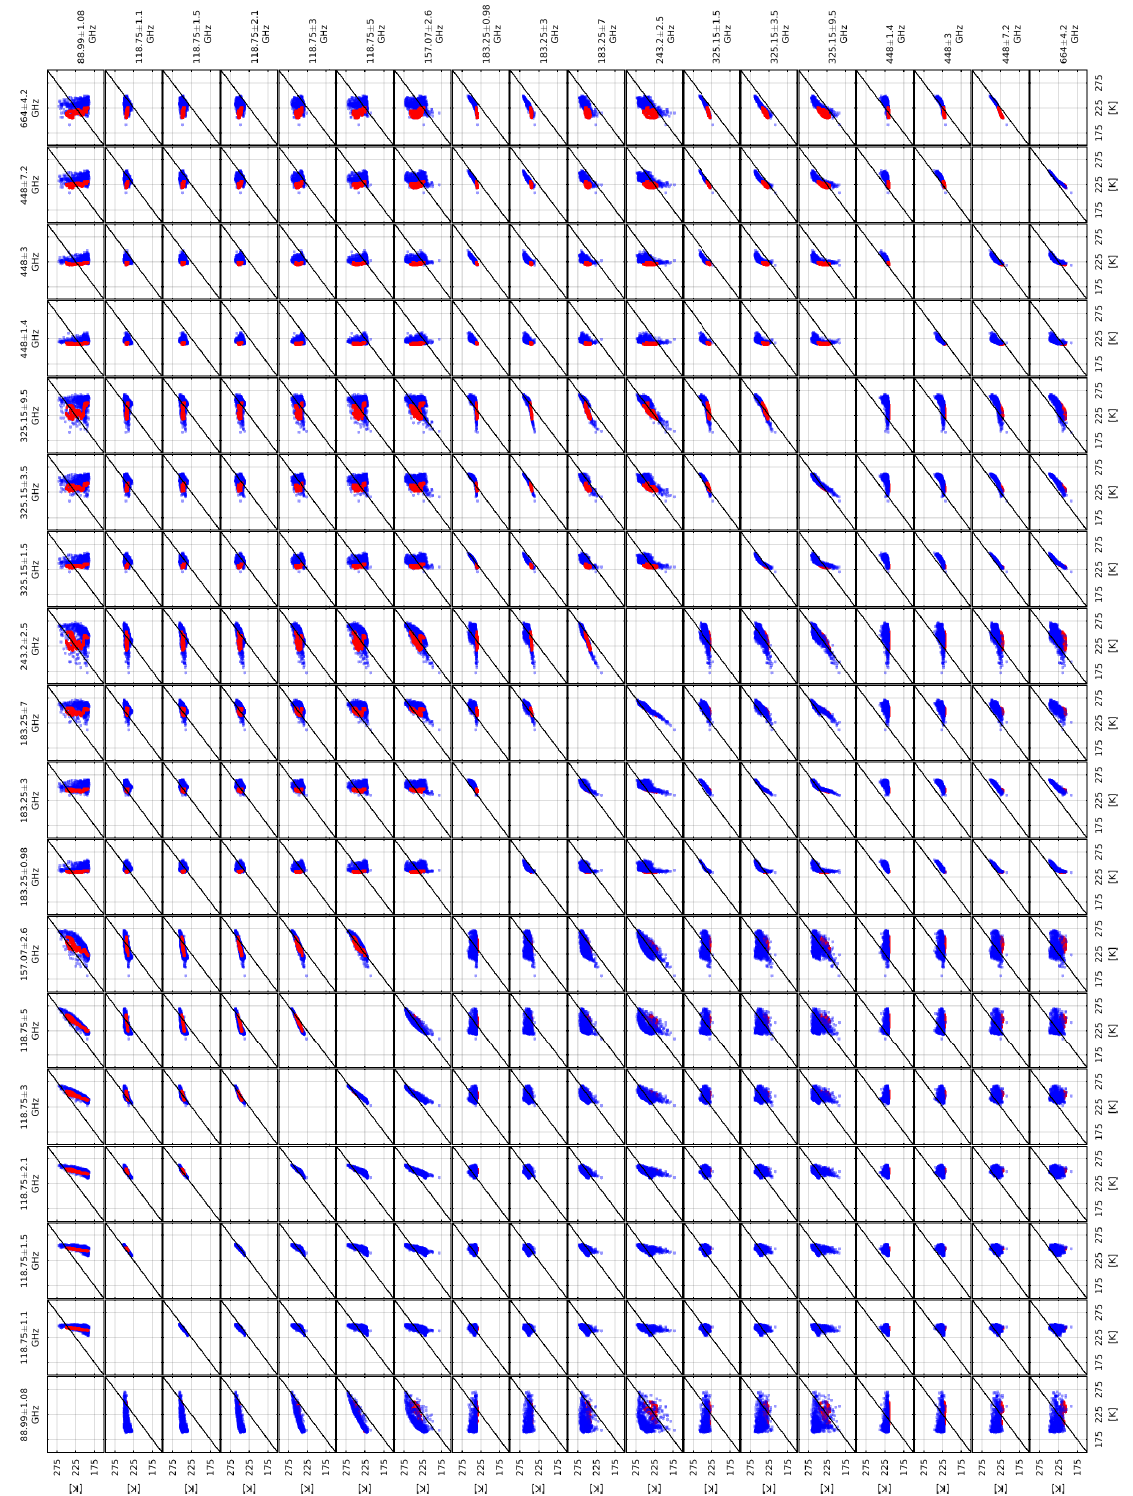
Figure 2. Comparison of simulated brightness temperature (blue) and measured brightness temperature of flight B897 (red). The channels indicated above and on the right correspond to the brightness temperatures on the x and y axes,